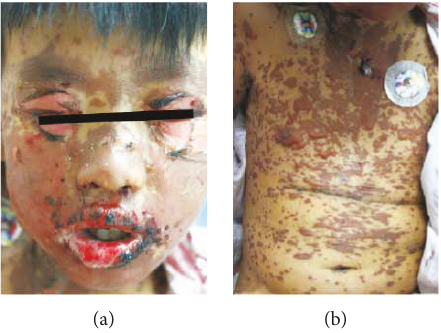
Figure 1: Typical cases of SJS from Chinese literature [20]. (a) Detachment of the eyelids, erosions and crusts of lips, and brownish macules on face and neck with scattered skin detachment. (b) Brownish macules with blisters and detachment on the trunk.